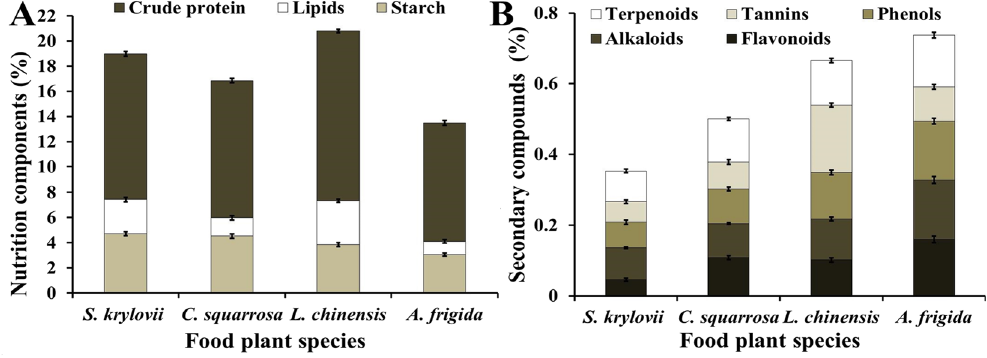
Figure 1. ( A ) Percentage nutrition components (crude protein, lipid, starch) and ( B ) secondary compounds (terpenoids, tannins, phenols, alkaloids, flavonoids) content ( ± SD, %) of the plant species C. squarrosa , L. chinensis , S. krylovii , and A. frigida ,